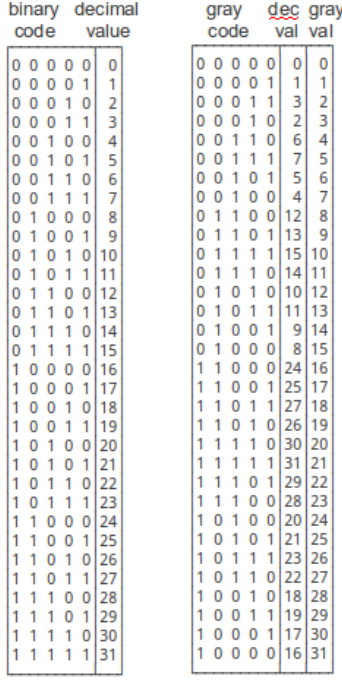
Figure 6: Binary and Gray encoding schemes